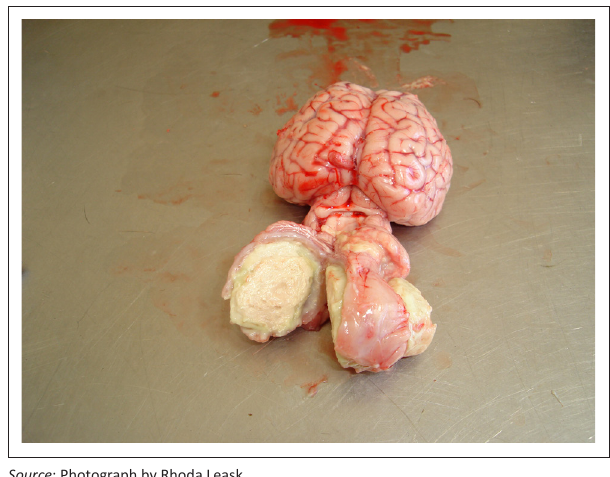
FIGURE 3: Cross-section of cerebellar abscess showing layered